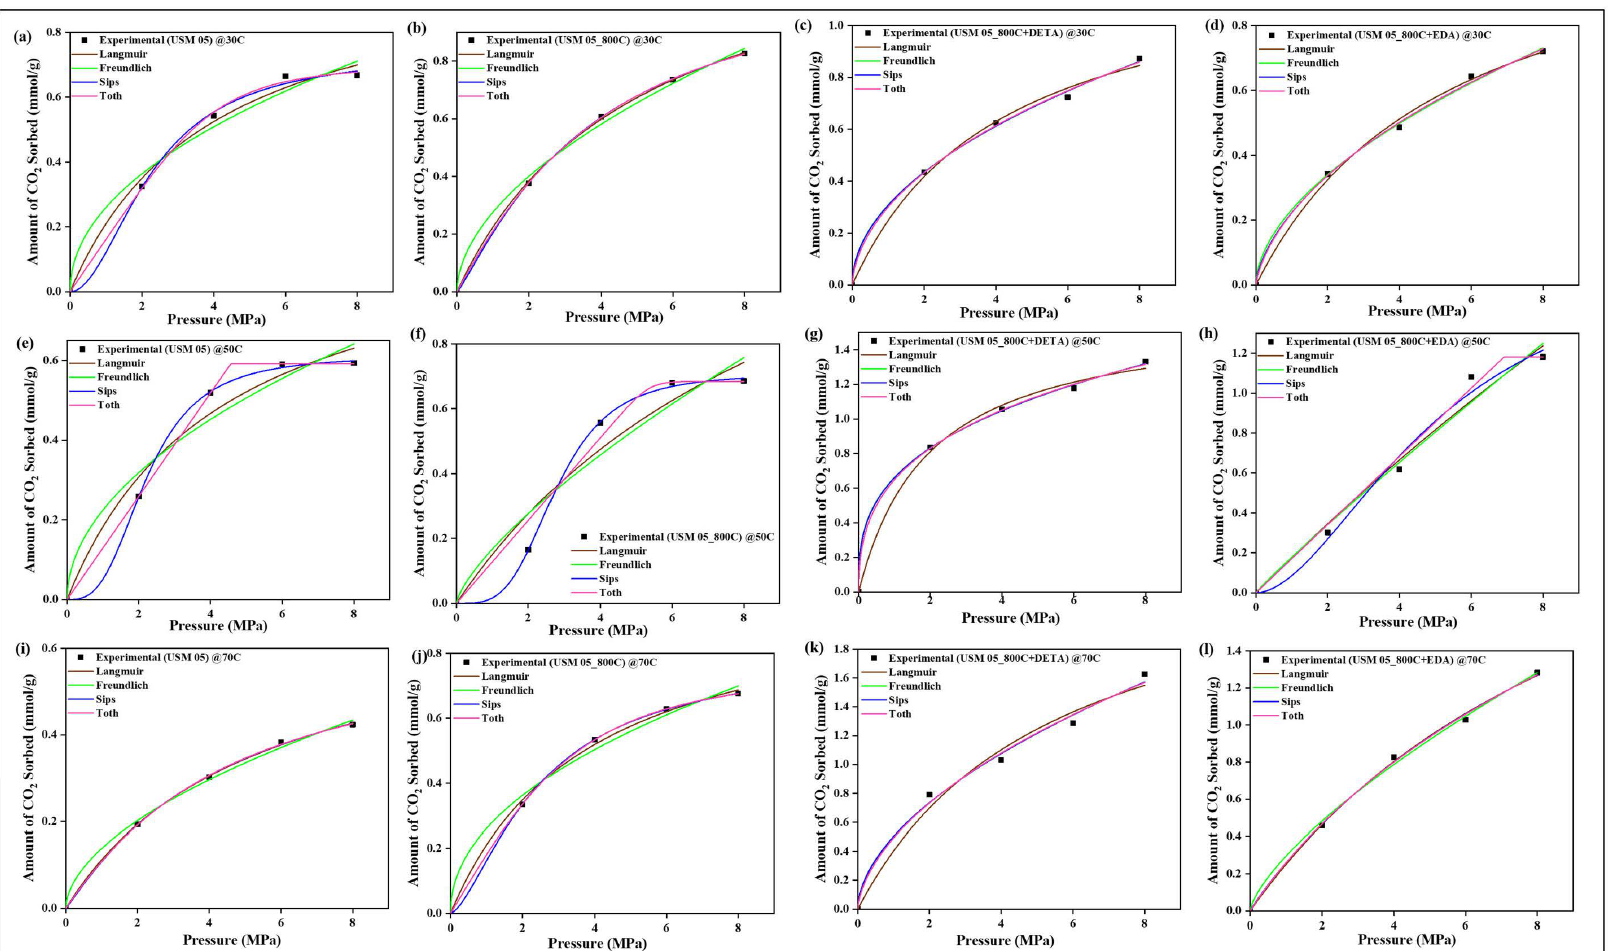
Figure 12. Prediction of the sorption behavior of USM 05 variants with Isotherm models at temperatures 30 ◦ C ( a – d ), 50 ◦ C ( e – h ), 70 ◦ C ( i – l ), and up to 8 MPa